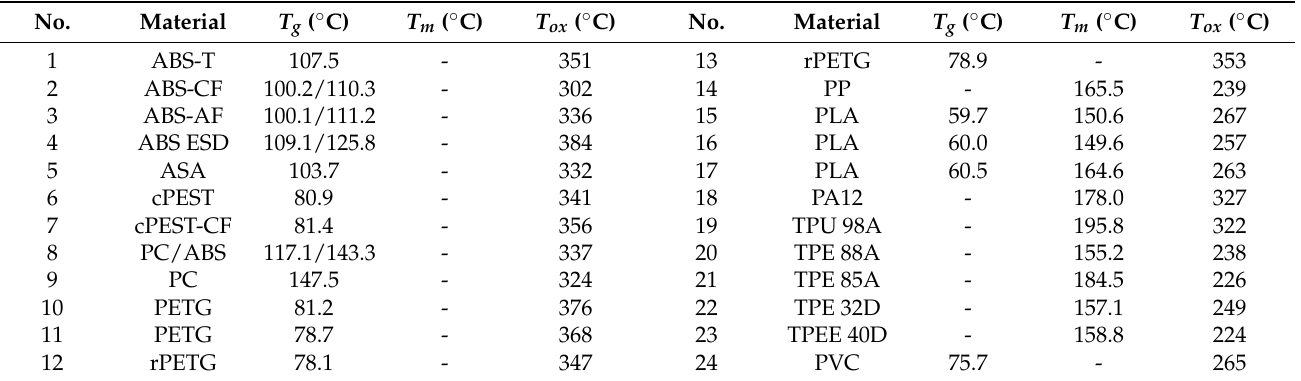
Table 2. Summary of DSC and STA